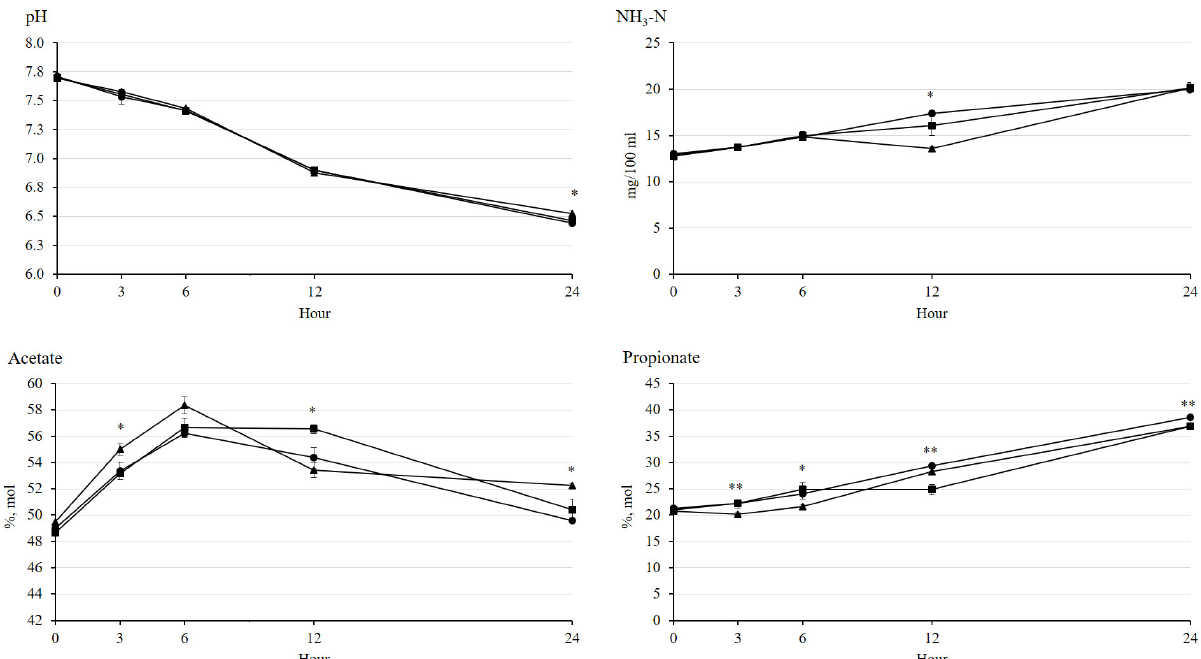
Figure 1. Changes in rumen pH and concentrations of NH 3 -N, acetate, and propionate during rumen incubation with oil sources containing essential fatty acid for 24 h. Diet with corn oil, C18:2n-6 (●); diet with linseed oil, C18:3n-3 ( ■ ); and diet with Ca-salt, protected C18:2n-6 ( ▲ ). The respective significance levels of dietary treatment, incubation time, dietary treatment × incubation time, and SEM for pH, NH 3 -N, acetate, and propionate are p < 0.001, p = 0.310, p = 0.376, and SEM=0.048; p < 0.001, p = 0.011, p < 0.001, and SEM = 0.864; p < 0.001, p = 0.002, p < 0.001, and SEM = 0.982; and p < 0.001, p < 0.001, p <0.001, and SEM = 1.007. Different symbols at the same time differ (*, p < 0.05; **, p < 0.01).